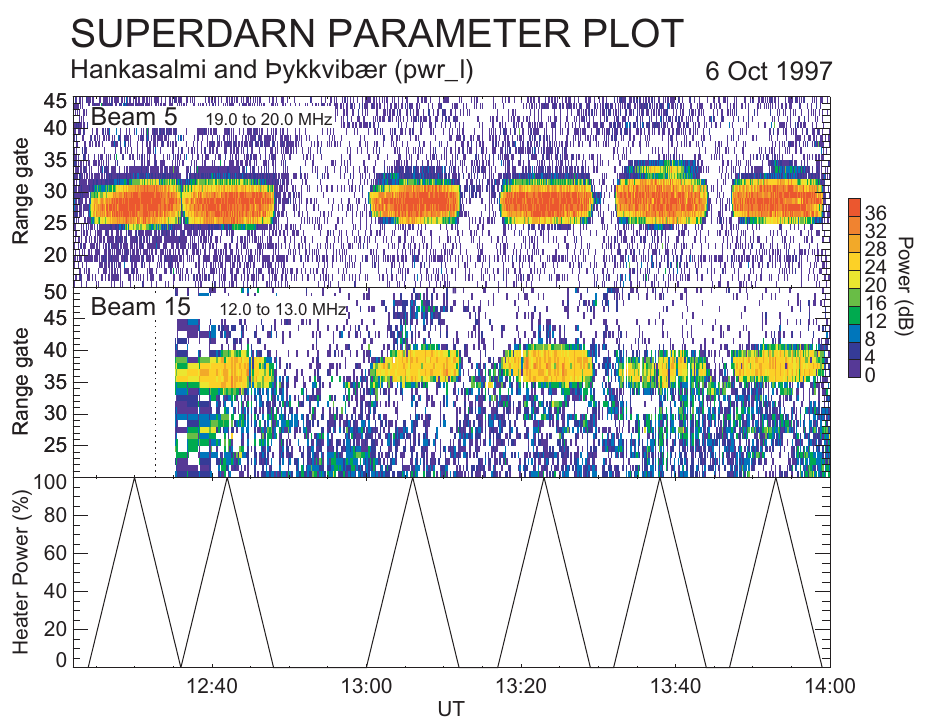
Fig. 3. Backscatter power (pwr l) measurements from the CUTLASS Hankasalmi (upper panel) and Pykkvibær (middle) radars during the power stepping experiment utilising the Tromsø heater on 6 October 1997. The lower panel shows the output heater power as a function of time during these